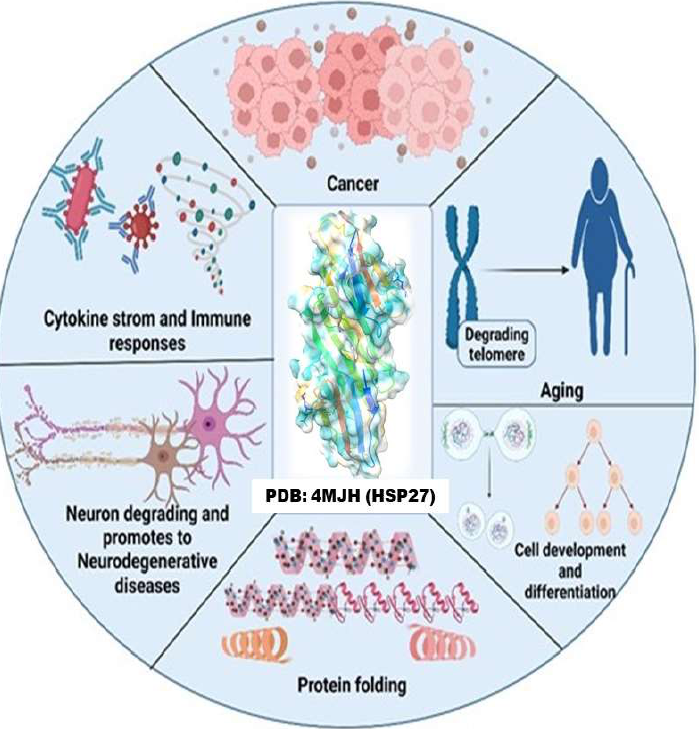
Figure 1. By chaperone activity, HSP27 regulates protein folding, regulates immune response, pro- motes cancer progression, induces resistance to anticancer therapeutics, increases aging, aggravation of neurodegenerative diseases, and differentiates cells [10–13].